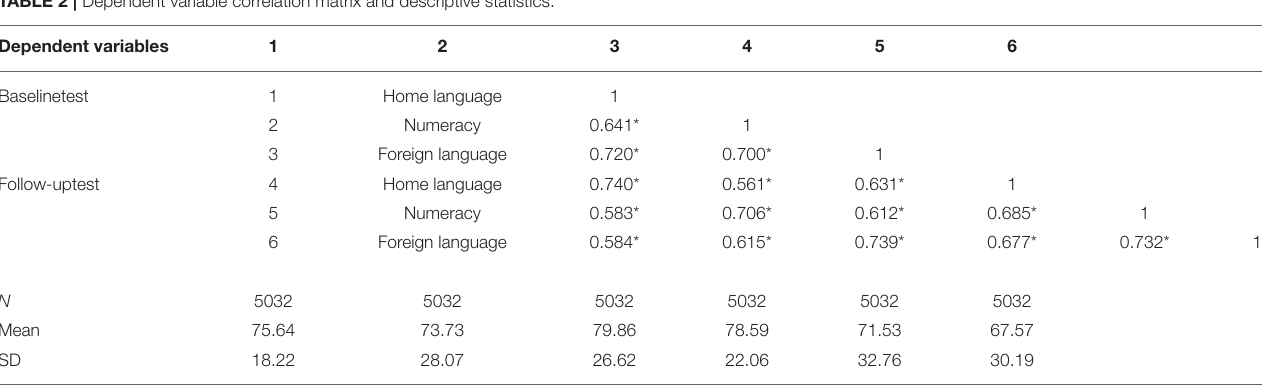
TABLE 2 | Dependent variable correlation matrix and descriptive